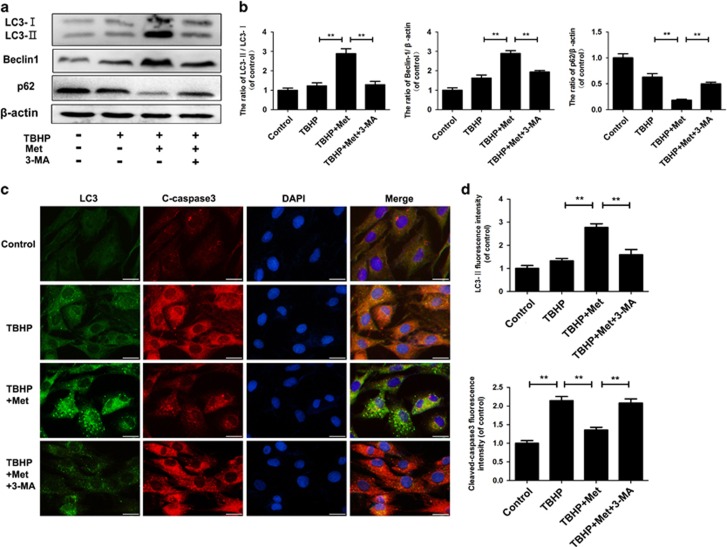
TBHP and 3-MA regulate autophagy in the nucleus pulposus cells. Nucleus pulposus cells were untreated (DMEM 10%FBS), or treated with TBHP alone, or treated with metformin (100 μM) and TBHP, or treated with TBHP and metformin (100 μM) combined with 3-MA (10 mM). (a,b)The protein expression of LC3, Beclin-1 and p62 in the nucleus pulposus cells as treated above. (c,d) Double immunofluorescence of LC3 protein and cleaved-caspase3 protein in nucleus pulposus cells. (Green signal represents LC3, red signal represents cleaved-caspase3, scale bar: 25 μm). The data in the figures represent the averages±S.D. Significant differences between the treatment and control groups are indicated as **P<0.01, *P<0.05, n=3